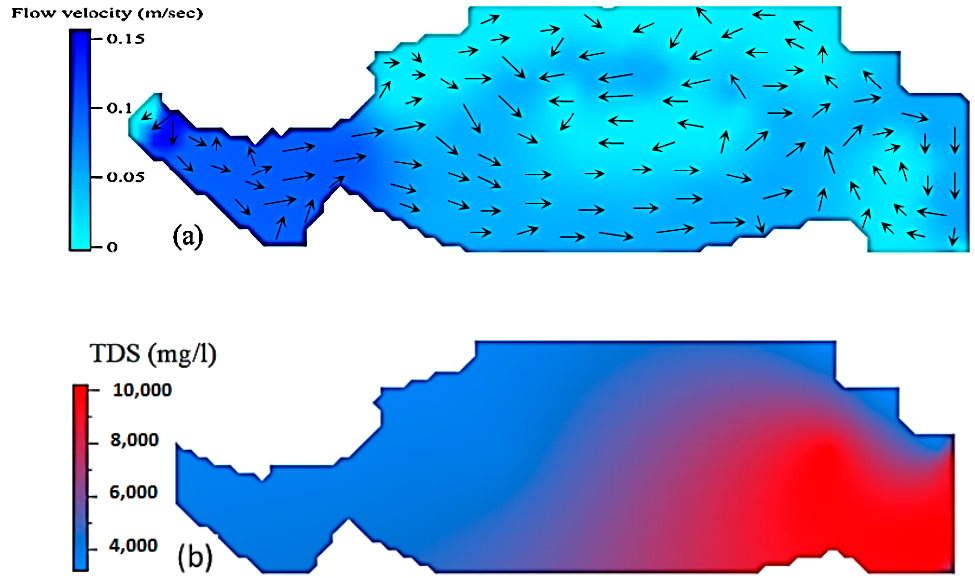
Figure 5. Distribution patterns of the flow velocity and TDS for the maximum inflow (Case 1). ( a ) Velocity pattern. ( b ) TDS pattern.